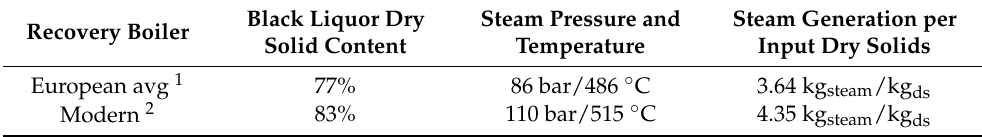
Table 5. Recovery boiler parameters: a European average and a modern